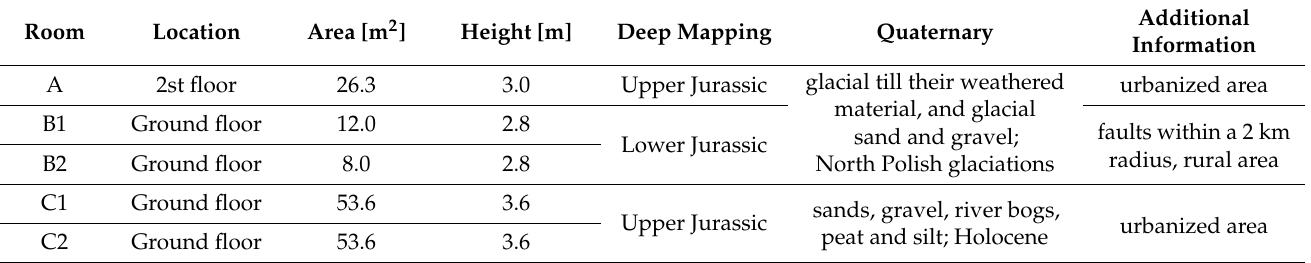
Table 2. The characteristics of individual rooms and the geological condition.